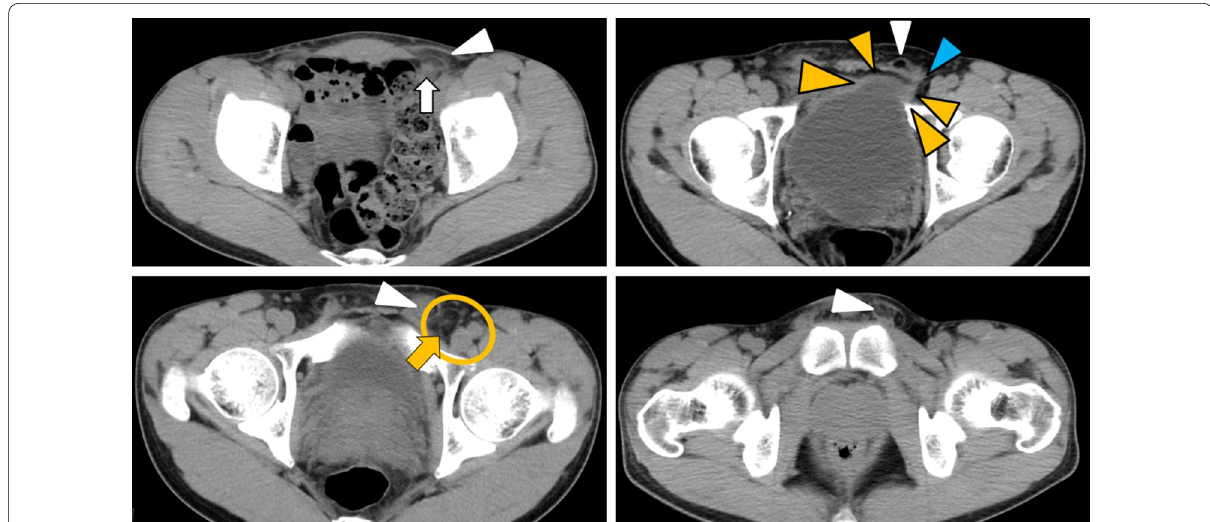
Fig. 1 Computed tomography (CT) performed five years before admission. CT showed a left indirect inguinal hernia (white arrowheads) which protruded from the outside of the inferior epigastric vessels (white arrow). A portion of the bladder (yellow arrowheads) was pulled to the left femoral ring (blue arrowhead). The small adipose tissue (yellow arrow) was observed in the left femoral canal (yellow